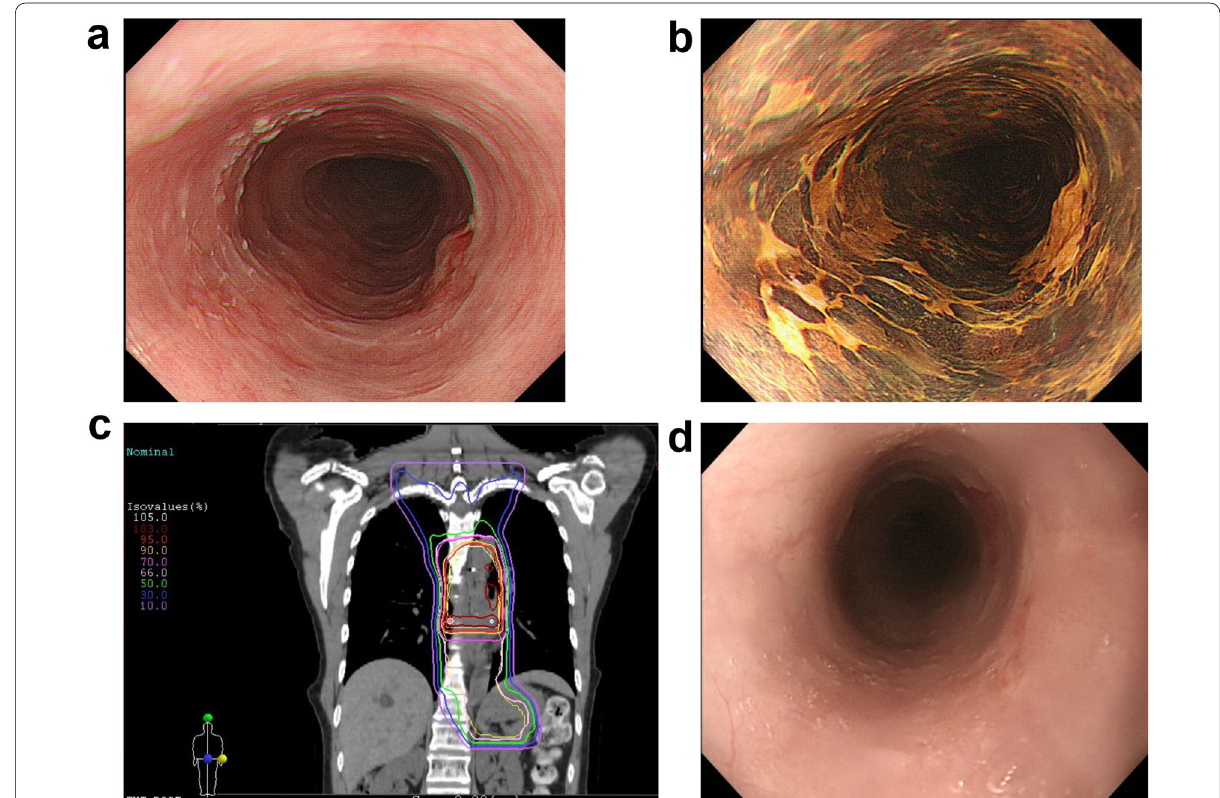
Fig. 1 Endoscopic examination prior to and after carbon-ion radiotherapy. a Upper gastrointestinal endoscopy showing a type 0-IIa lesion located 27–29 cm from the incisors. b Chromoendoscopy with iodine staining revealing a lugol-voiding lesion with distinct margin. c Dose distribution of the carbon-ion radiotherapy. The isodose line of 95% is indicated by the orange line. d Examination 4 months after carbon-ion radiotherapy. The patient achieved a complete